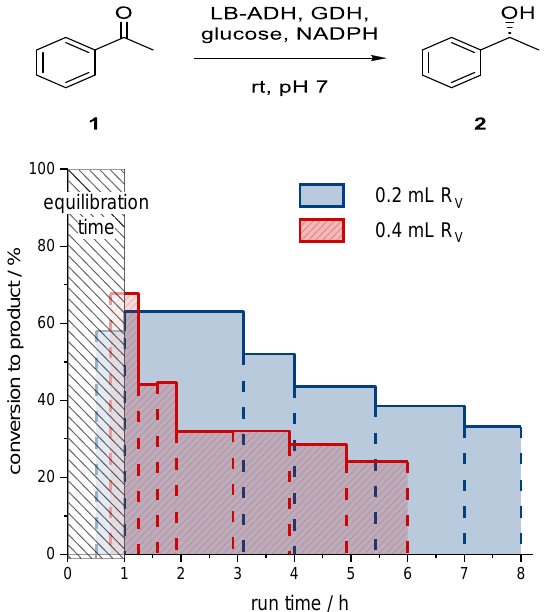
Figure 14. Conversion of acetophenone ( 1 ) to 1-phenylethanol ( R )- 2 using superabsorber-immobilized ADH with a co-immobilized GDH-based cofactor regeneration system in a packed bed reactor. Horizontal lines show conversion for fractions collected between times indicated with dashed vertical lines. Reactor volume: 0.2 mL or 0.4 mL (glass reactor, inner diameter: 5 mm), residence time: 1 h, catalyst loading: 2 U, temperature: room temperature, c substr (organic): 100 mM.